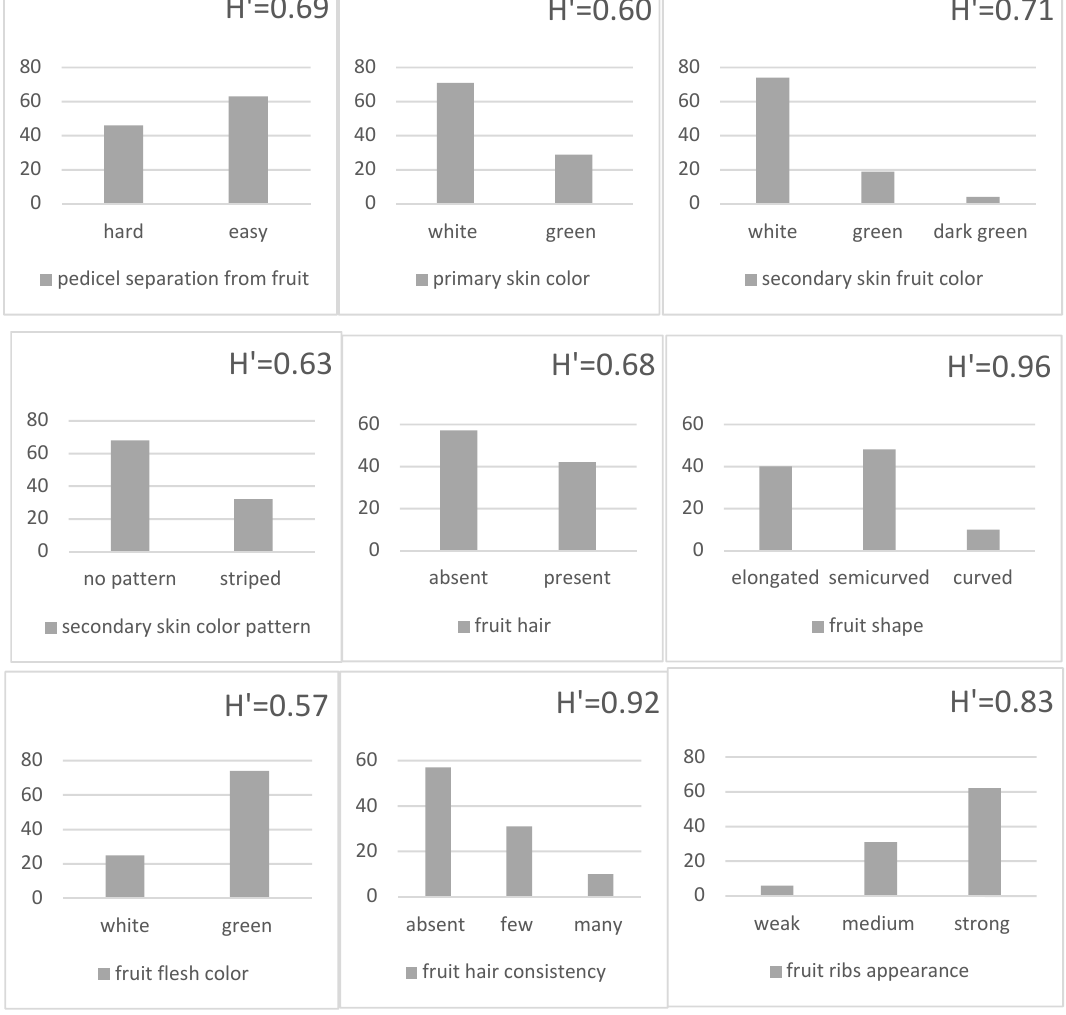
Figure 3. Diversity indices and frequencies for polymorphic qualitative traits recorded for the Lebanese snake melon accessions.